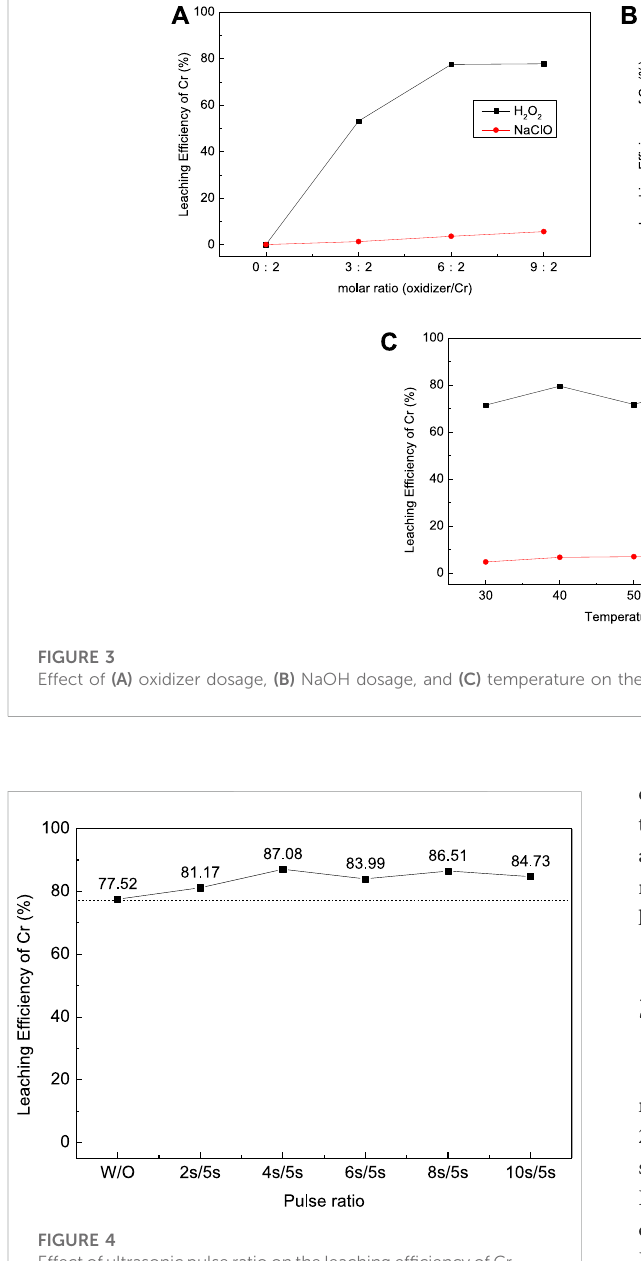
FIGURE 4 Effectofultrasonicpulseratioontheleachingef fi ciencyofCr for chromium sludge